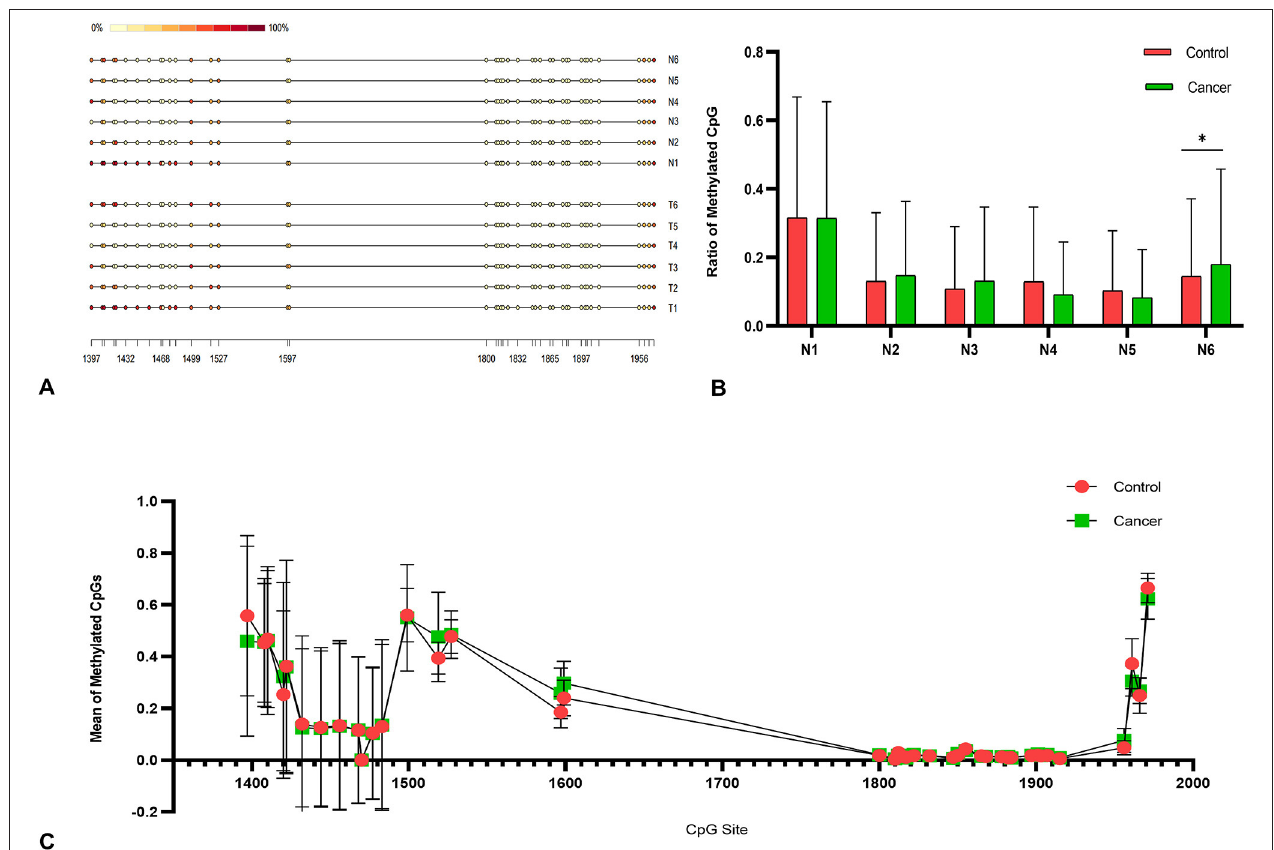
FIGURE 5 | Methylation analysis of ABCC9 promoter. (A) Methylation analysis of ABCC9 CpG island. (B) Methylation CpG levels of six samples. (C) Methylation levels in average CpG sites. *indicates a significant difference between the two groups, P <